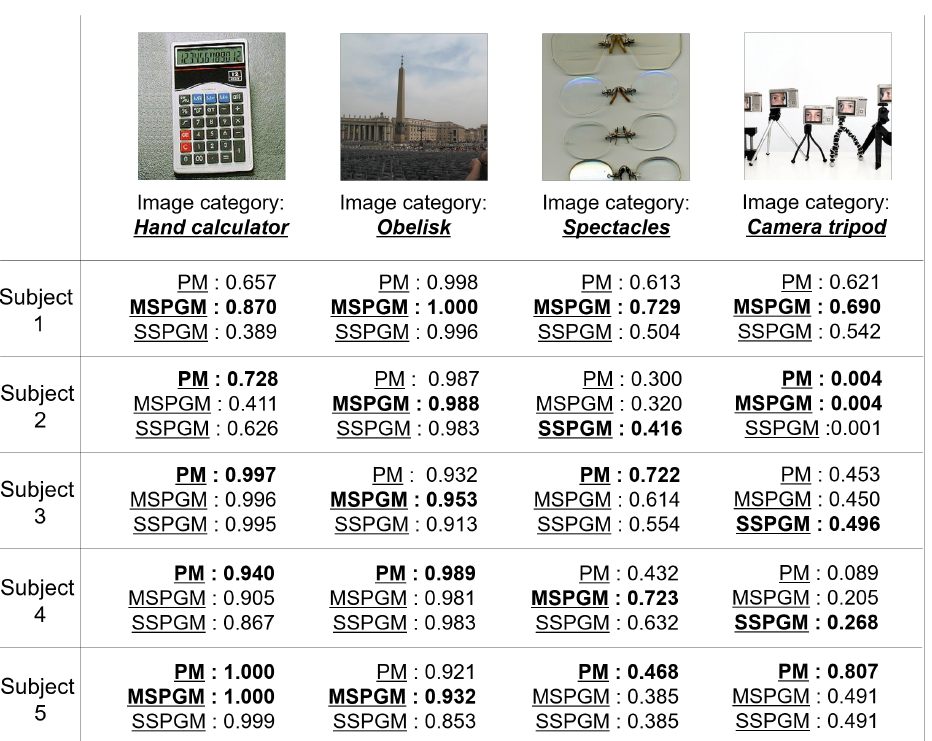
Figure 6. Examples of the category estimation results of PM and two CMs (MSPGM and SSPGM) based on PGM. The confidence category scores range from 0 to 1, and the best scores for each subject are shown in